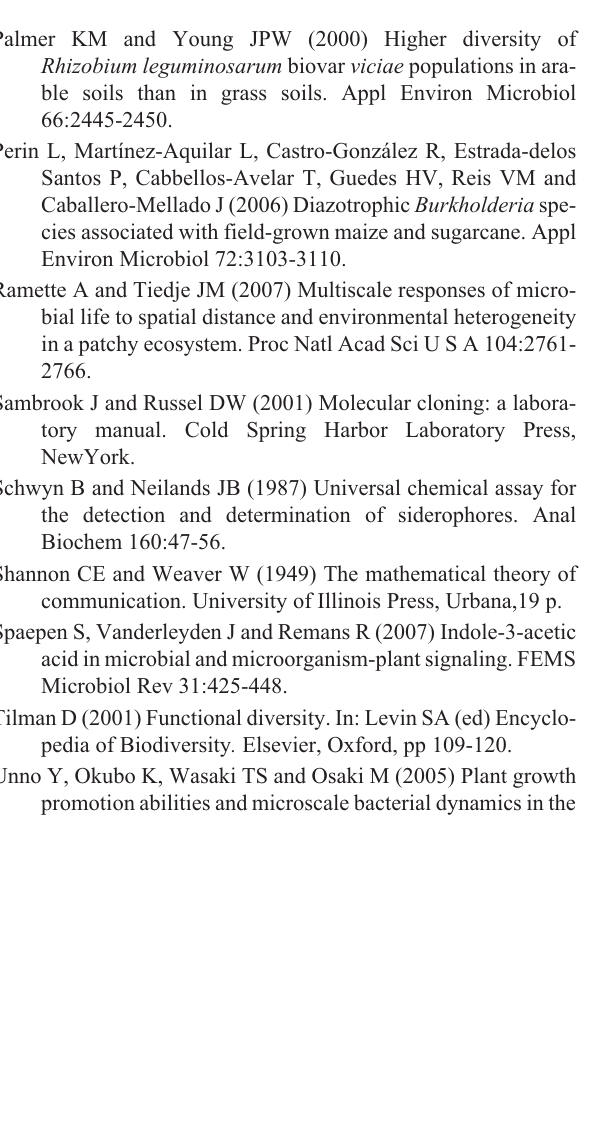
Table S1 – Input dataset for MCA analysis. Table S2 – Input dataset for CatPCA